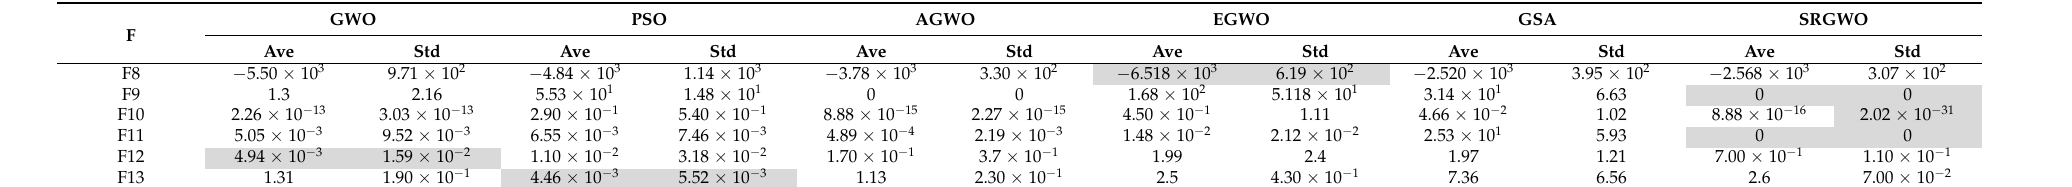
Table 2. Simulation results of multi-modal functions.